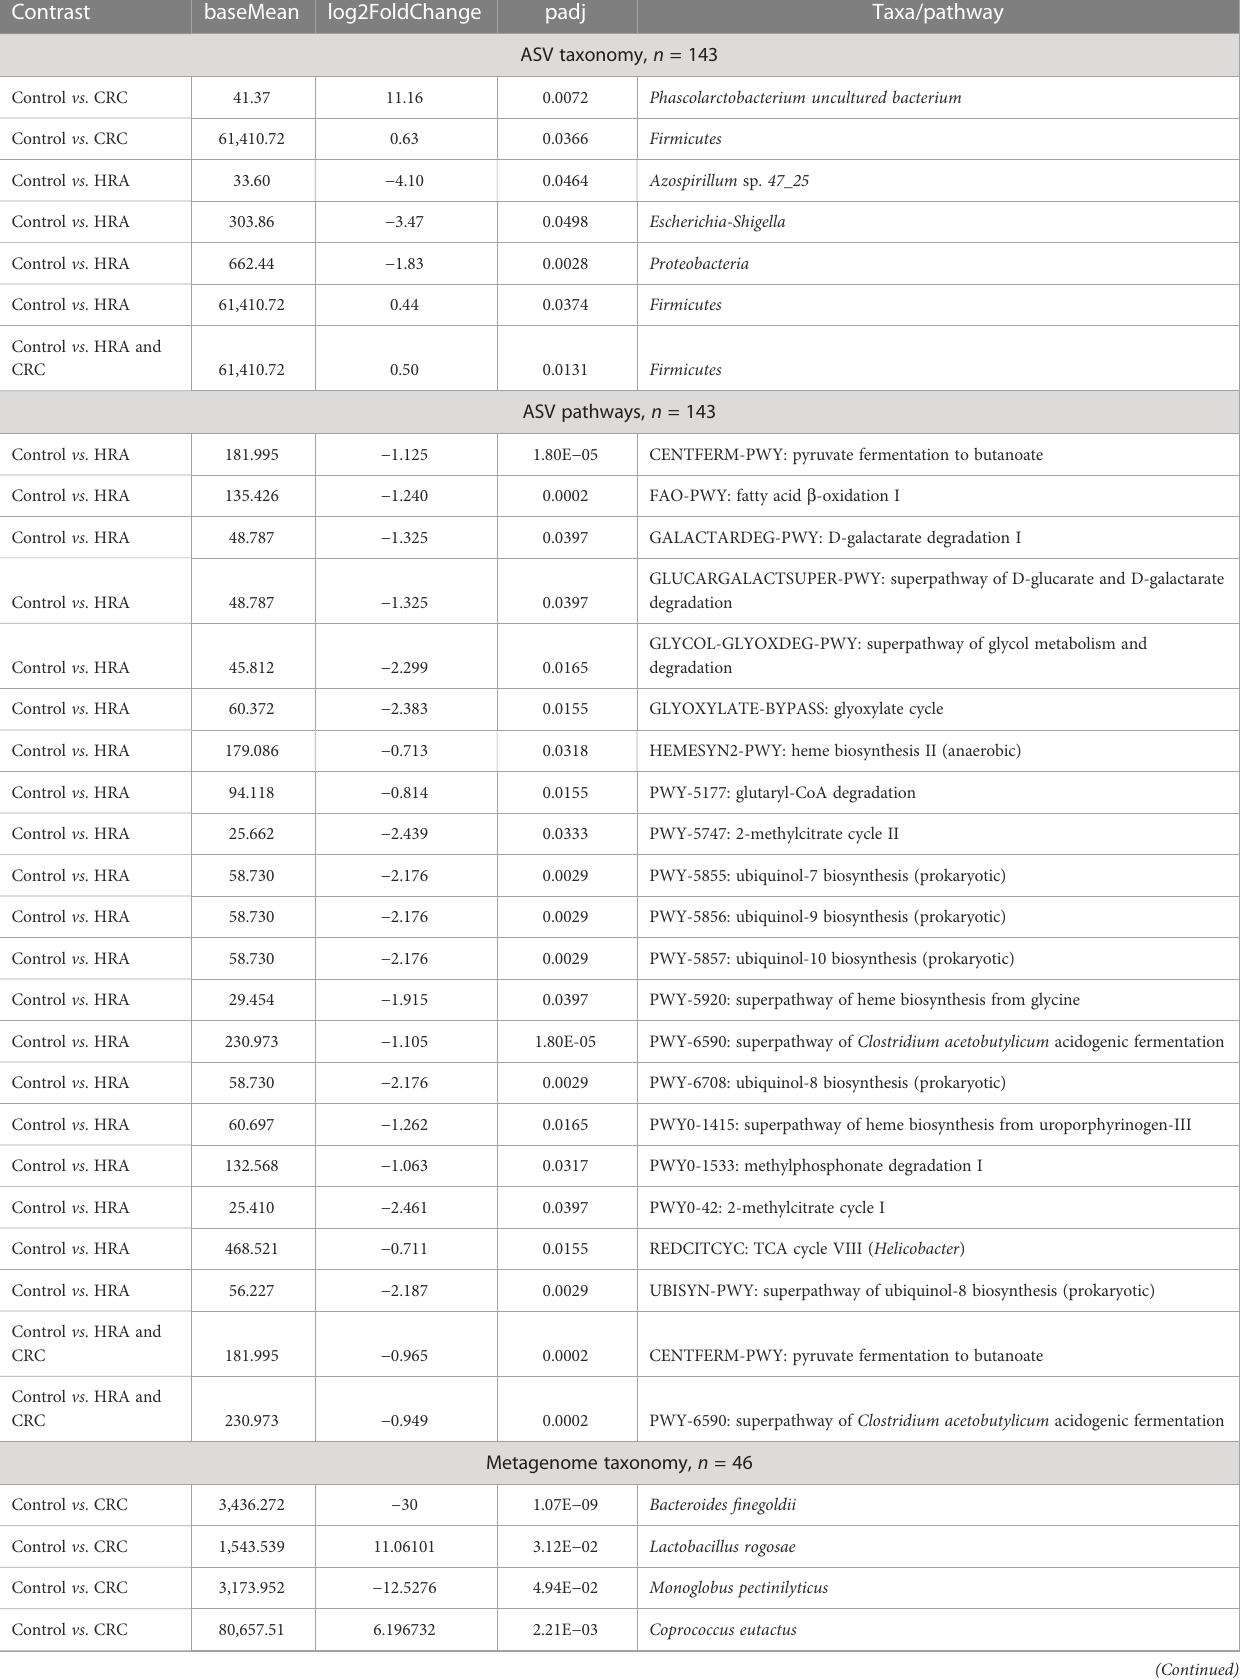
ASV taxonomy, n = 143